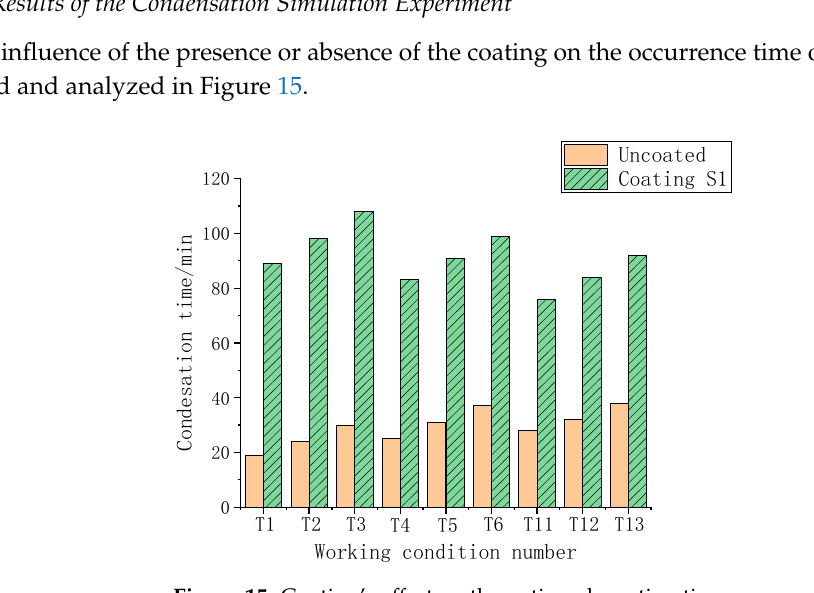
Figure 15. Coating’s effect on the anticondensation time.